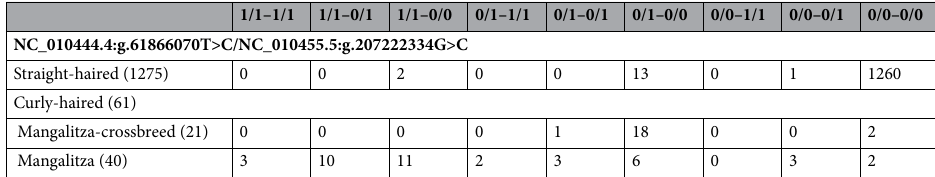
Table 2. Validation of candidate variants for curly hair development in an imputed dataset of a total of 1336 individuals. The genotypic distribution of combined genotypes of the two investigated variants NC_010444.4:g.61866070T>C (CYP4F3) and NC_010455.5:g.207222334G>C (TRPM2) detected in 61 curly- haired and 1275 straight-haired pigs is demonstrated by numbers of homozygous wild type (0/0), heterozygous (0/1) and homozygous mutant (1/1)